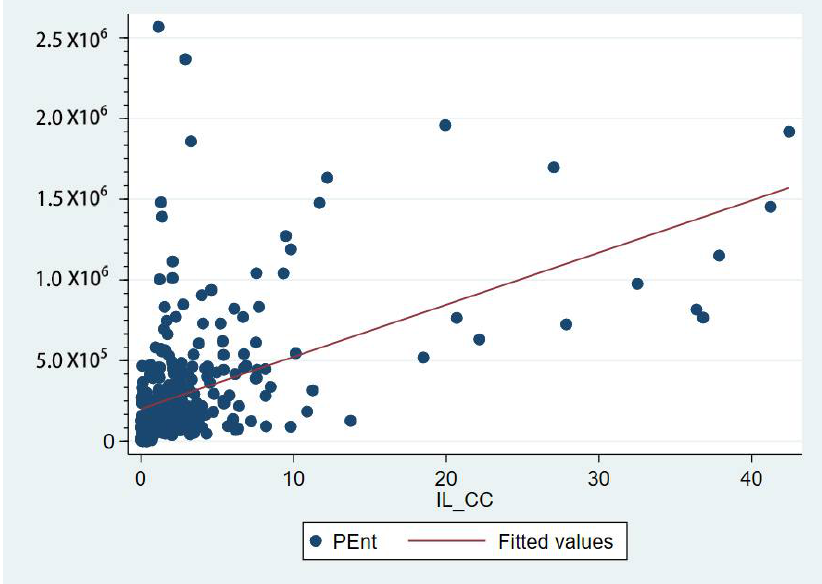
Figure 3. Relationship between performances in art venues and entrepreneurship. Source: China Statistical Yearbooks, China Economic Census Yearbook and the website of Chinese Intangible Cultural Heritage.